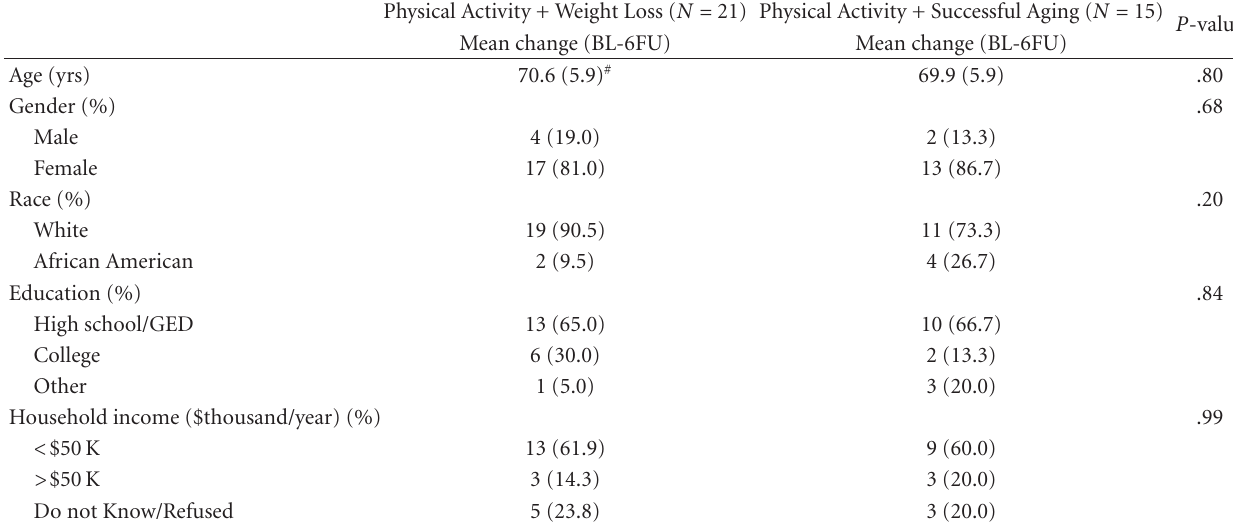
Table 1: Baseline demographic variables.